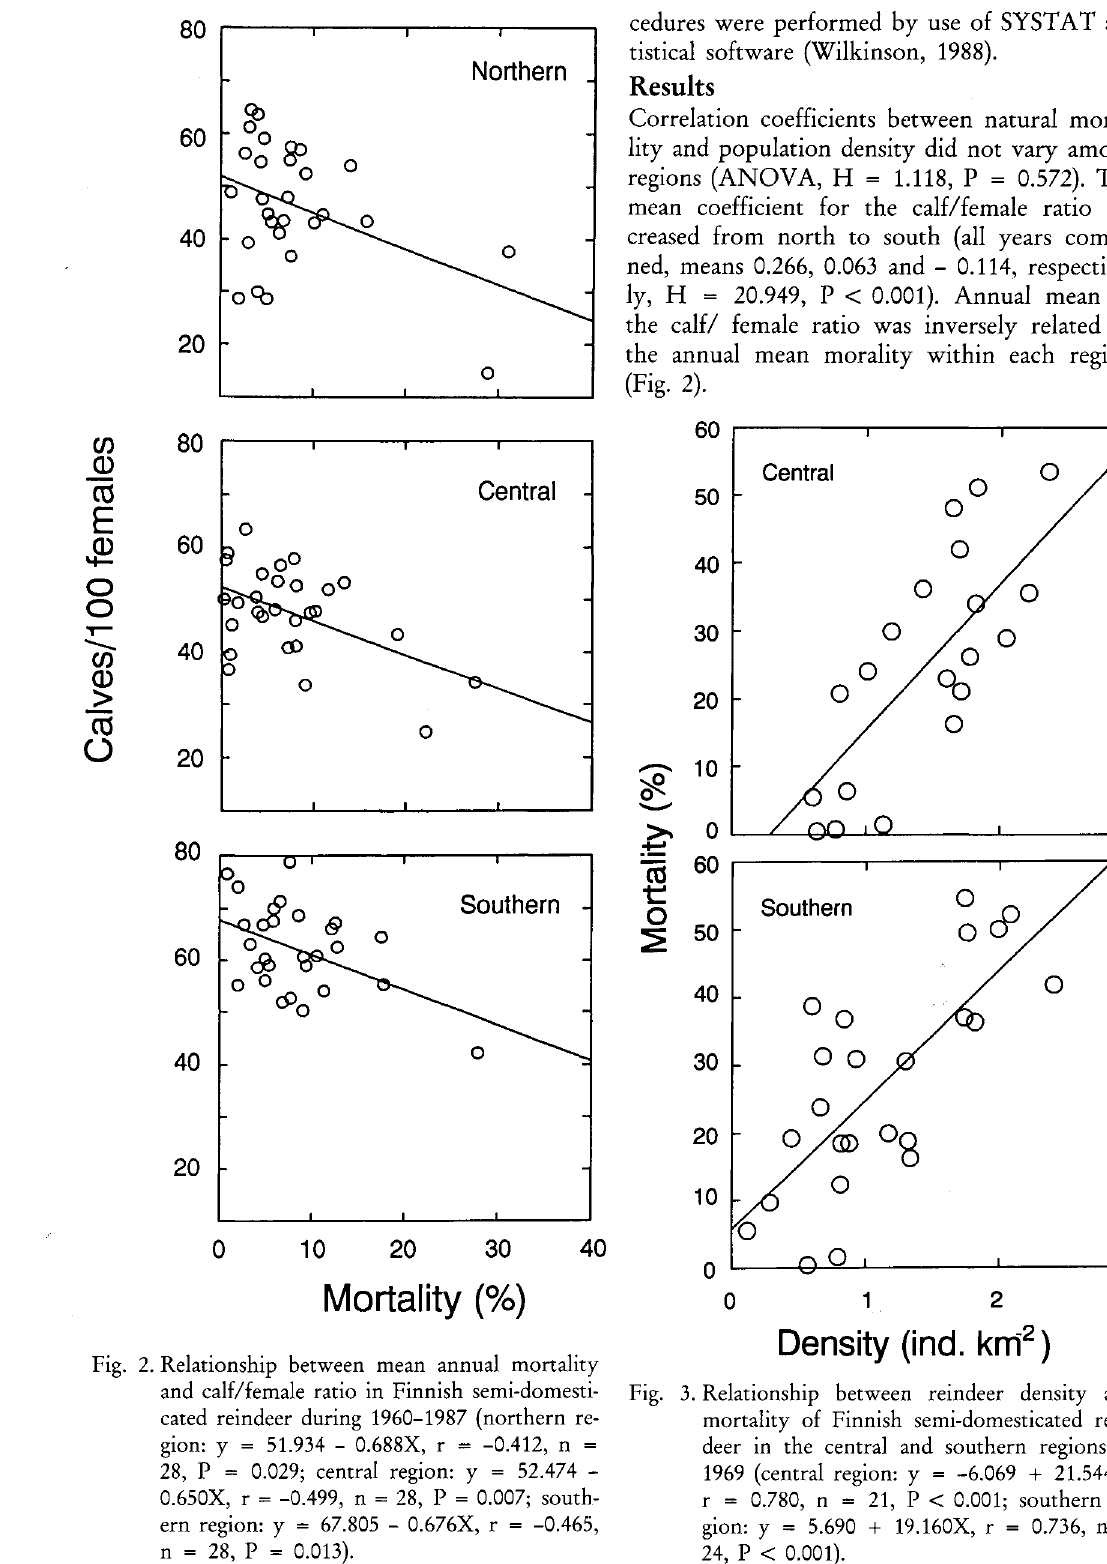
Fig. 3. Relationship between reindeer density and mortality of Finnish semi-domesticated rein deer in the central and southern regions in 1969 (central region: y = -6.069 + 21.544X, r = 0.780, n = 21, P < 0.001; southern re gion: y = 5.690 + 19.160X, r = 0.736, n = 24, P <